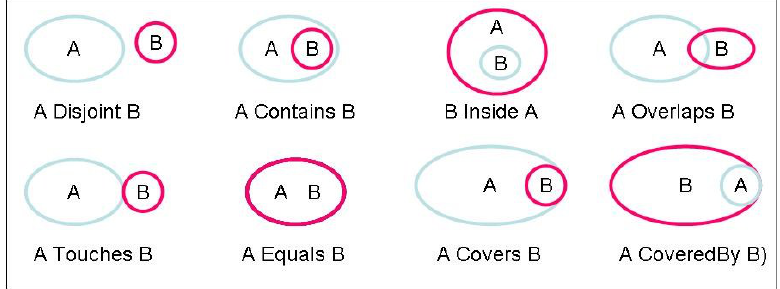
Figure 2. Egenhofer topological relations